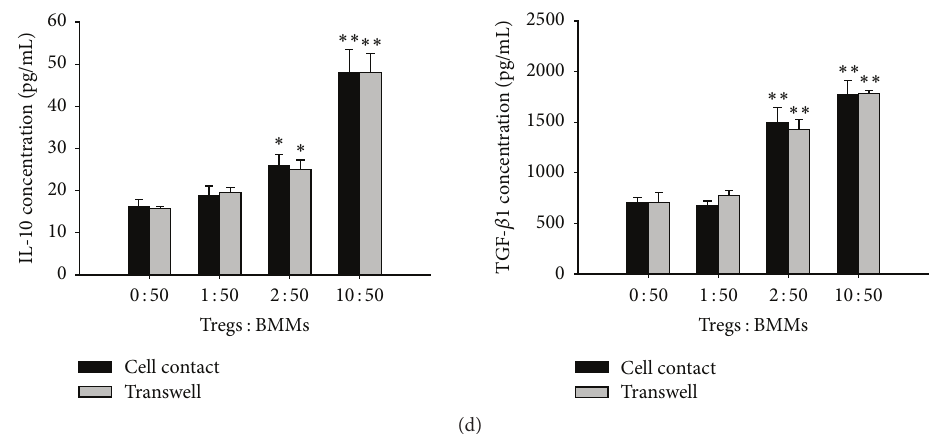
Figure 1: The cocultures of activited Tregs and BMMs. Activated Tregs and BMMs were cocultured for 5 or 12 days at different ratios in either cell contact wells or Transwells in the presence of 20 ng/mL M-CSF and 100ng/mL RANKL. (a) The purification of Tregs was assessed by flow cytometry. (b) The cells were stained with TRAP, and the TRAP-positive cells containing 3 or more nuclei were scored. Scale bars = 100 𝜇 m. (c) The area of the bone resorption pits of the osteoclasts was visualized by toluidine blue staining and measured using an image analysis program. Scale bars = 100 𝜇 m. (d) The IL-10 and TGF- 𝛽 1 levels in the coculture supernatants were measured by ELISA. ∗ 𝑃 < 0.05 and ∗∗ 𝑃 < 0.01 compared with the control groups (BMM alone